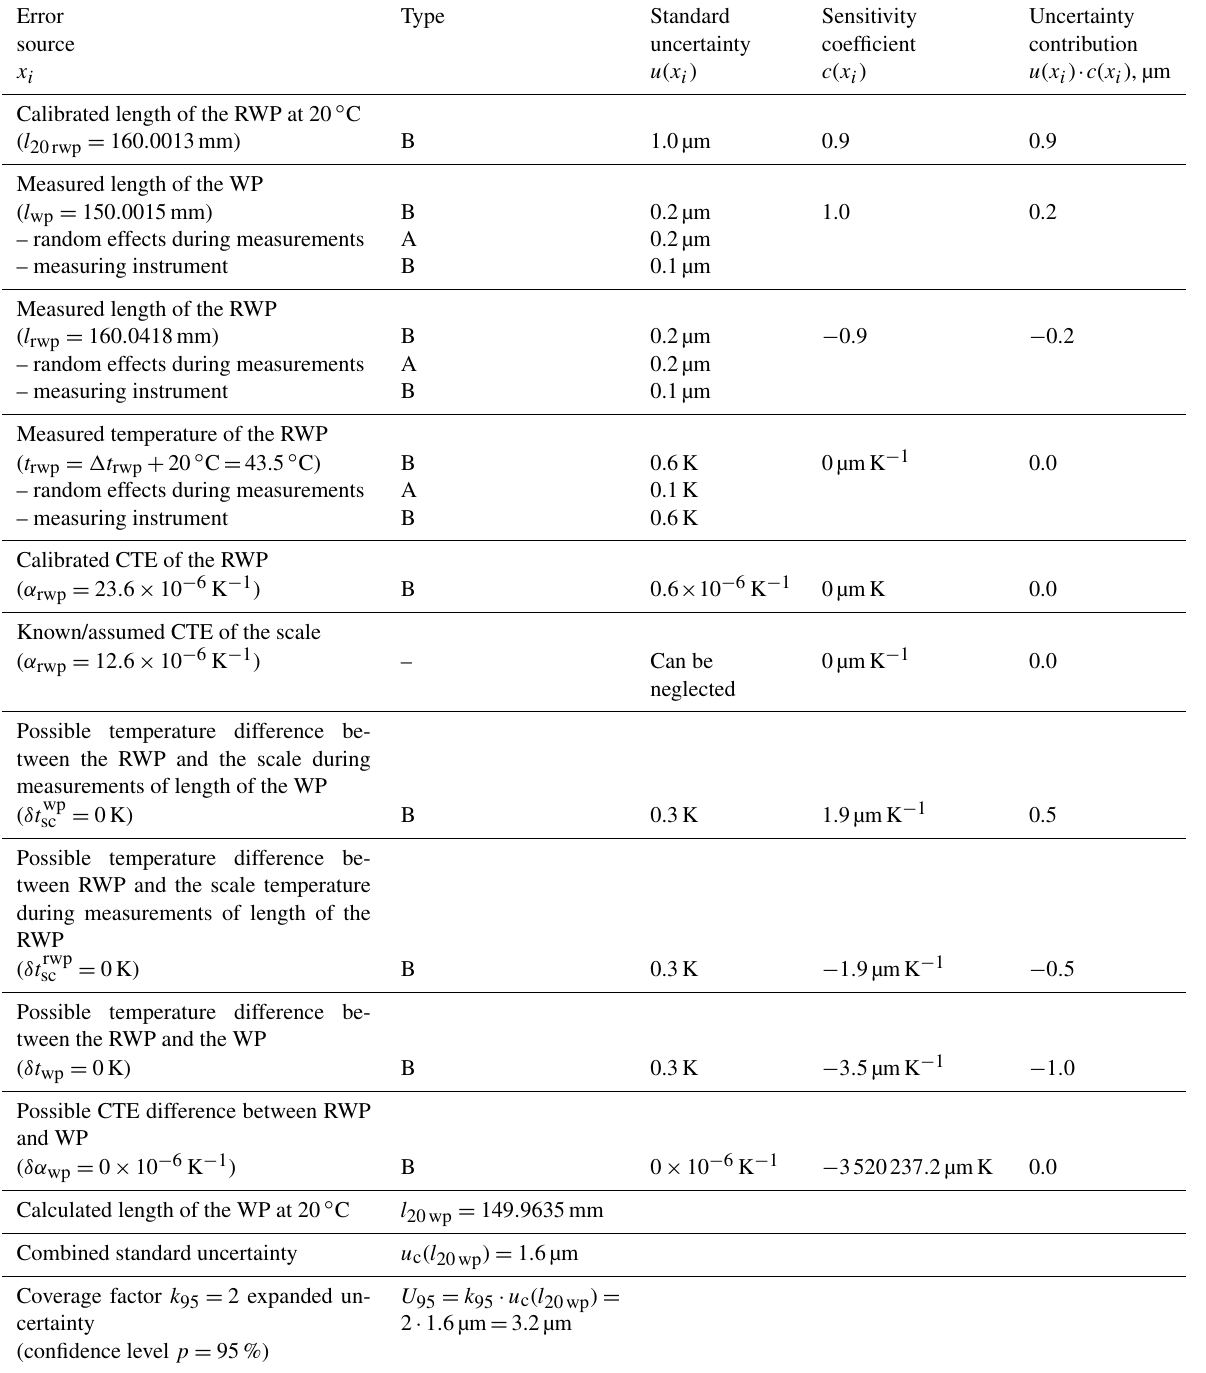
Table 2. Uncertainty budget for example